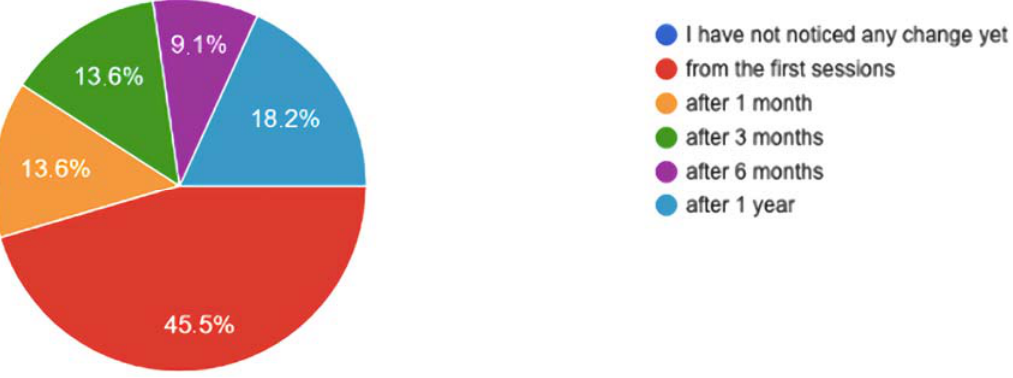
Figure 6. Degree of incidence in the mental health aspects improved by the practice of mindfulness.